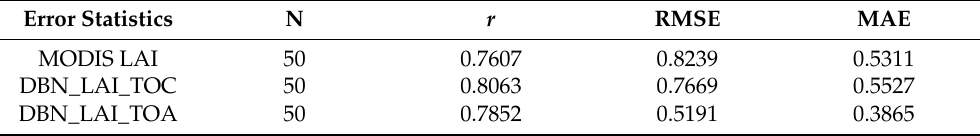
Table 4. Error statistics of the verification